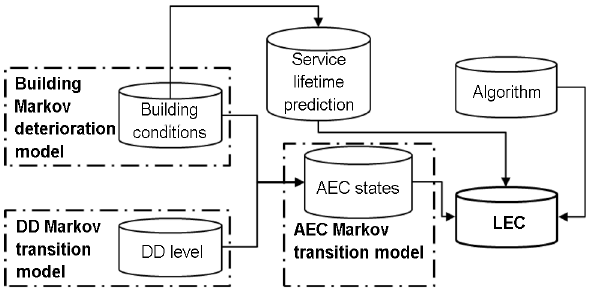
Fig. 3. The stochastic lifecycle energy consumption model (AEC represents Annual Energy Consumption; DD represents Degree-day; LEC represents Lifecycle Energy Consumption)